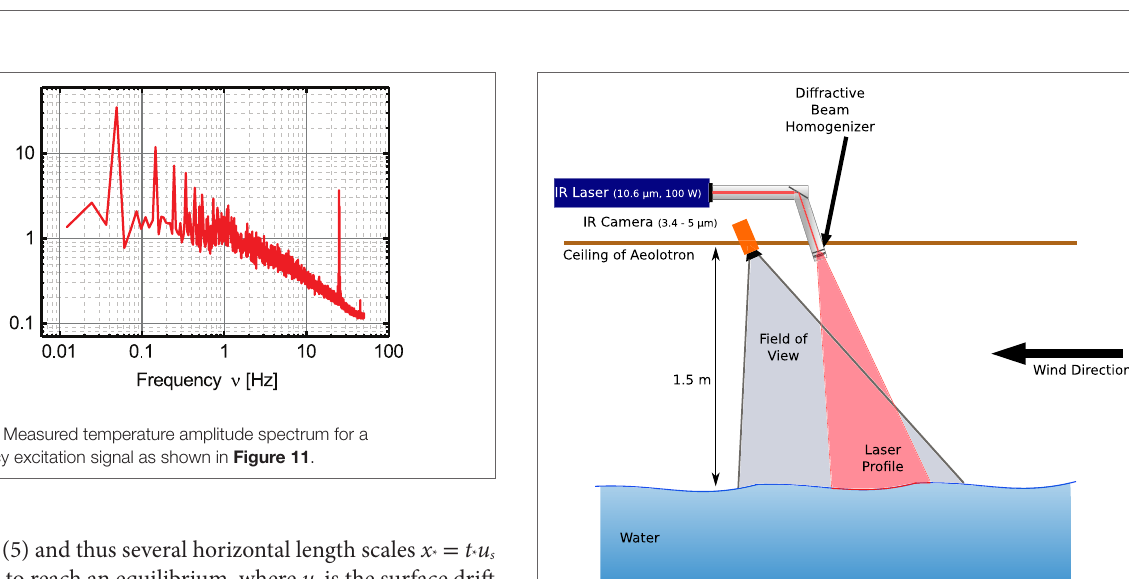
FigURe 11 | The upper two figures show the excitation signal and the corresponding excitation spectrum for a frequency of 25 Hz. The lower two figures show a multifrequency excitation signal with frequencies of 0.049 and 25 Hz and the corresponding excitation spectrum. The used duty cycle for both frequencies is 50%. The spectrum obtained from a measurement with this multifrequency excitation is shown in Figure 12 .